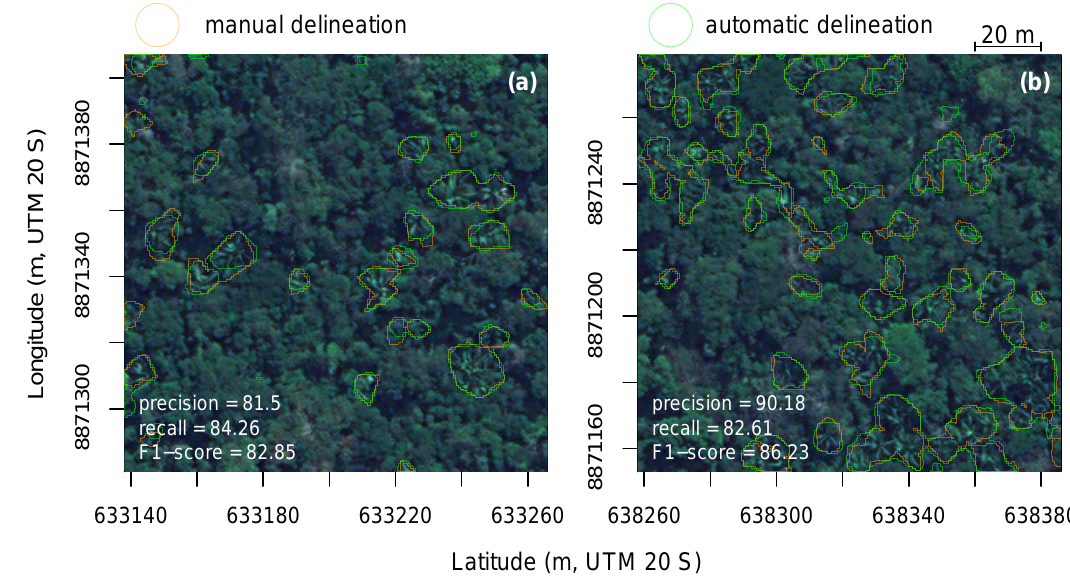
Figure 4. Example of validation images ( a and b , 256 delineation in orange and the U-net delineation in green. Precision, recall and F1-score are computed for each image. Satellite image courtesy of the DigitalGlobe